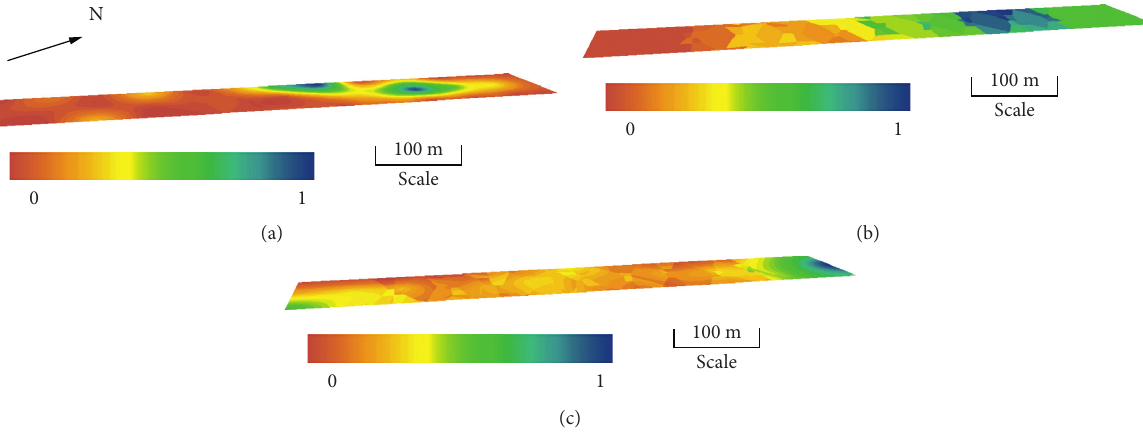
11 ;(b) water yield of L 10 ; (c) water yield of L 8 .